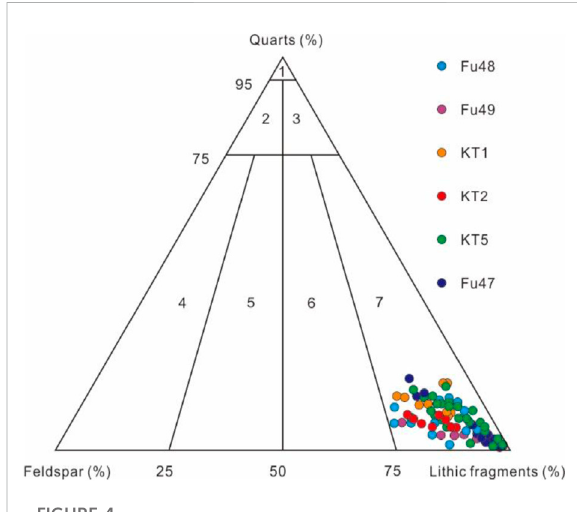
FIGURE 4 Petrologicalclassi fi cationoftheP 3